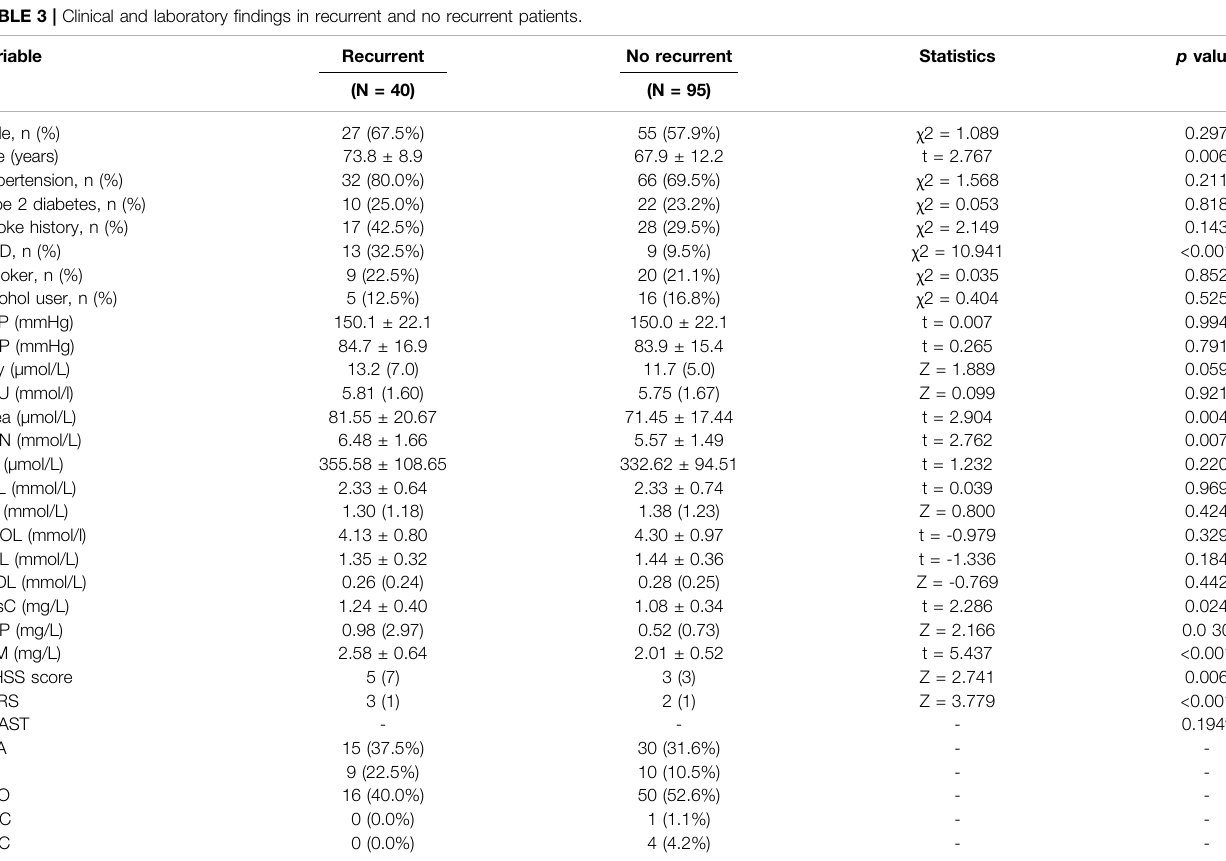
TABLE 3 | Clinical and laboratory fi ndings in recurrent and no recurrent